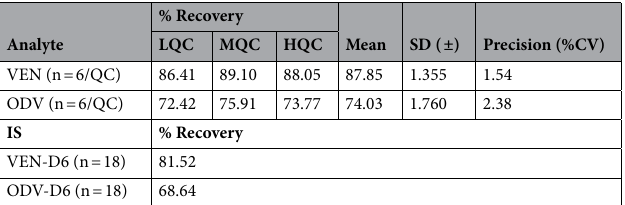
Table 9. SPE based recovery of VEN, ODV, VEN-D6, and ODV-D6.